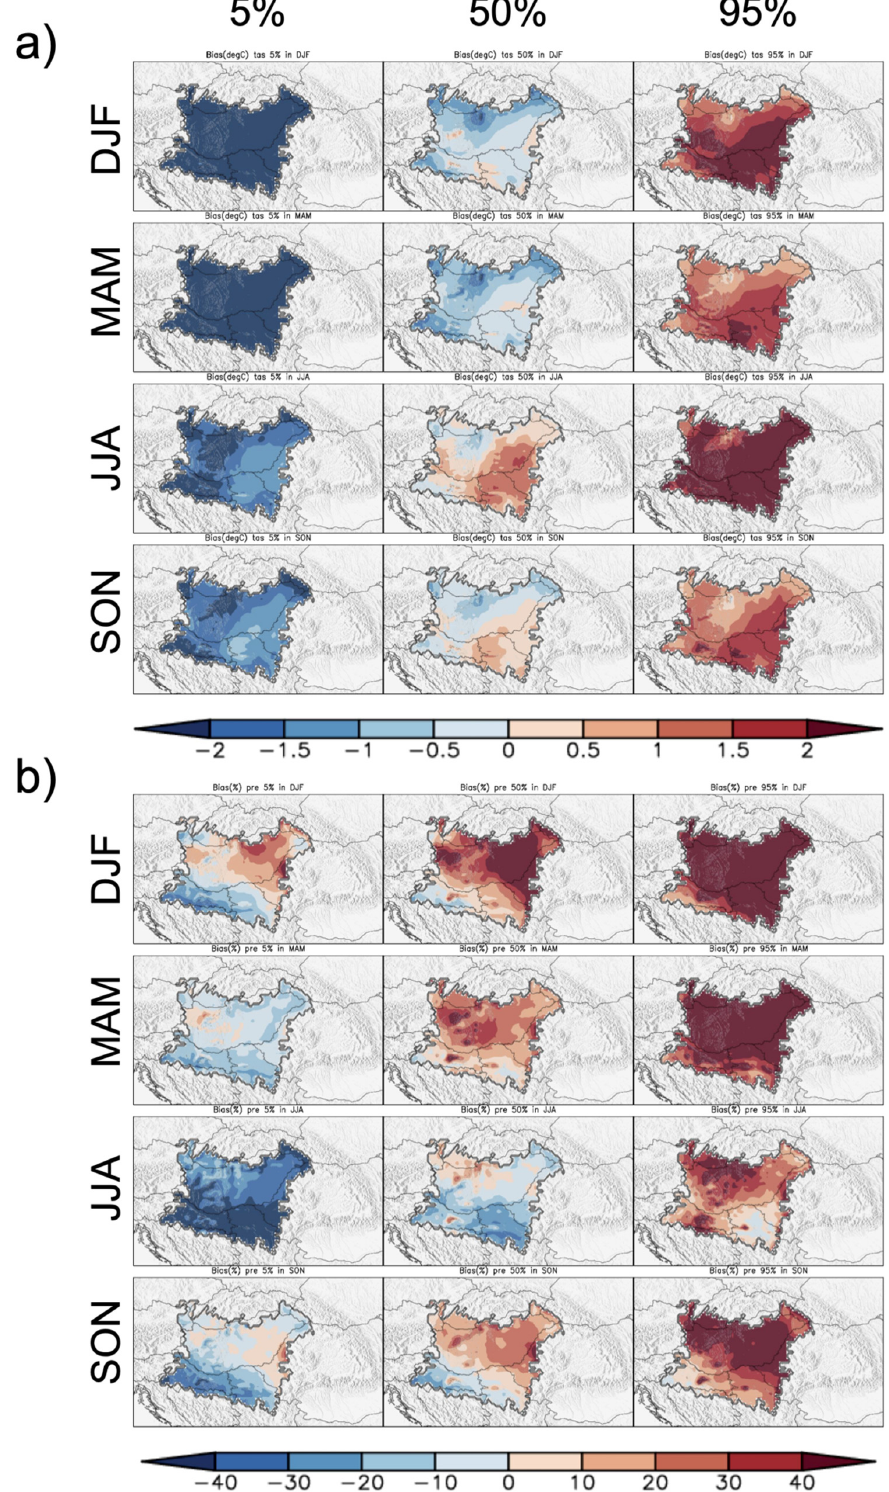
Figure 3. Distribution of ( a ) mean temperature biases (1971–2000) and ( b ) mean precipitation biases (1971–2000) for the winter season (DJF), spring season (MAM), summer season (JJA), and autumn season (SON). First row, left: 5th percentile of the mean RCM temperature bias among the 30 RCM simulations. Middle: median of the mean RCM temperature bias distribution. Right: 95th percentile of the mean RCM temperature bias distribution.